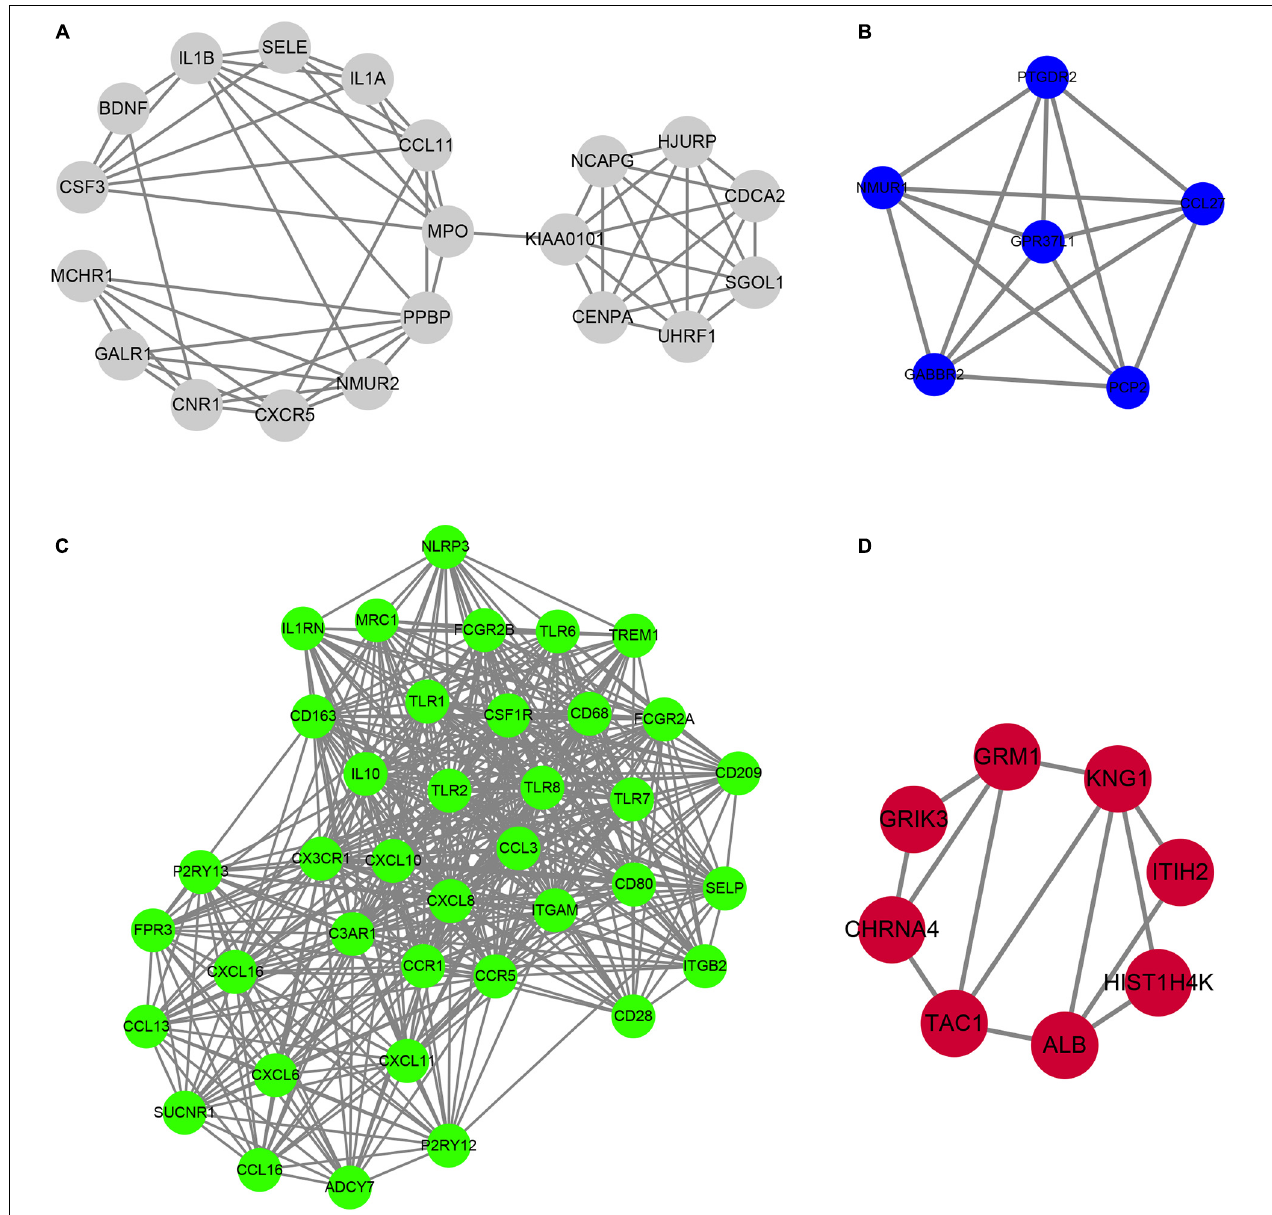
FIGURE 6 | Construction of hub PPI networks in the hub modules. (A–D) The hub PPI network was constructed in gray module (A) , blue module (B) , turquoise module (C) , and brown module (D)